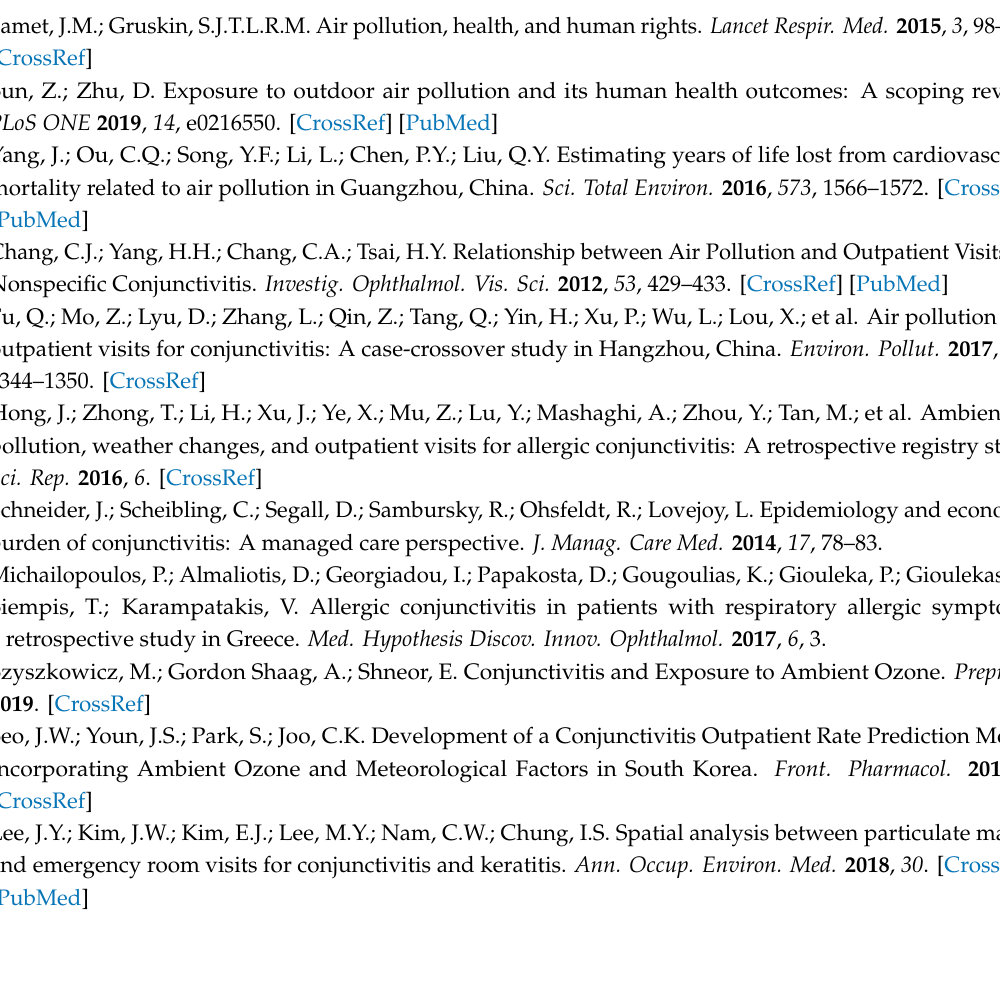
Figure A1. Funnel plot of PM 10 and O 3 on conjunctivitis using Trim-fill method. The solid circles denote effect estimates from included studies and open circles denotes estimates provided by Trim-fill method.